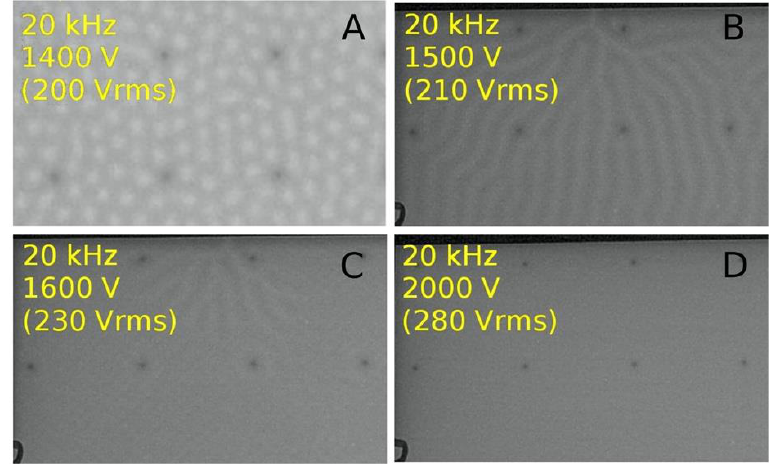
Figure 5. Patterns during ignition ( A ) 1400 V, ( B ) 1500 V, ( C ) 1600 V and ( D ) 2000 V [16]. Camera Dimage A2 Konika Minolta, 1/25 s, F5.6 iso 4000.